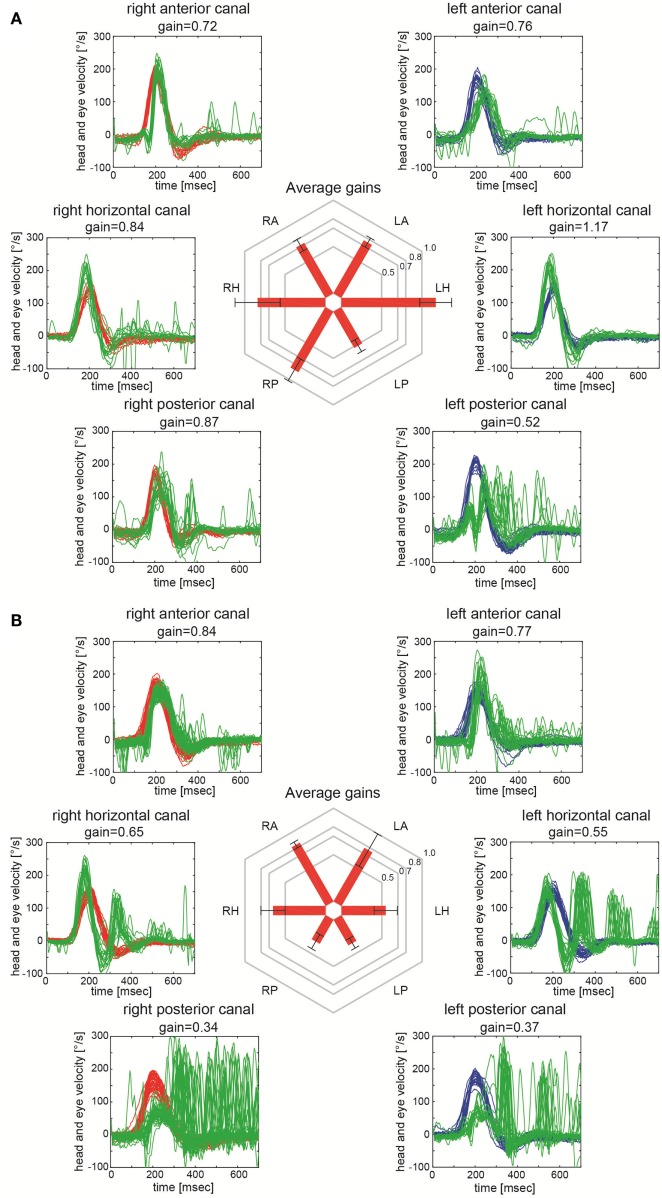
Video-head-impulse testing in two patients with internuclear ophthalmoplegia (INO). Eye velocity traces (in green) and head velocity traces (in red for testing the right vestibular organ and in blue for assessing the left vestibular organ) are plotted against time. Summary plots in the center illustrate average individual vestibulo-ocular reflex (VOR)-gains ± 1SD for all six canals. (A) Significant VOR-gain reduction accompanied by overt catch-up saccades in the contralesional (left) posterior semicircular canal (PSC) in a patient with right-sided INO (patient 7; see also MR-image in Figure 1A). Note that all other canals showed normal responses. (B) Significant VOR-gain reduction and catch-up saccades in both PSCs and both HSCs in a patient with bilateral INO (patient 19; see also MR-image in Figure 1B).